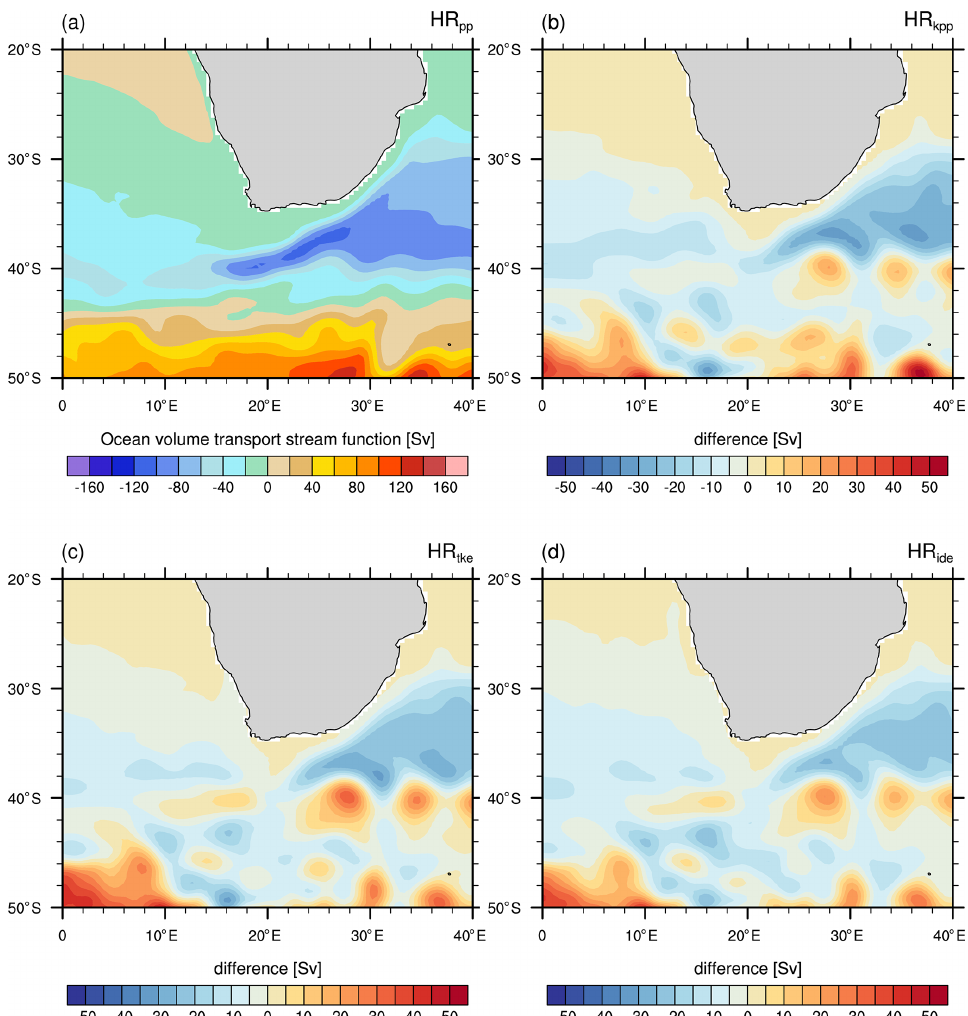
Figure 8. Time-averaged, vertically integrated volume transport in the Agulhas region south of Africa as simulated by MPI-ESM1.2 (a) HR pp and the difference (experiment minus HR pp ) for (b) HR kpp , (c) HR tke , and (d) HR ide